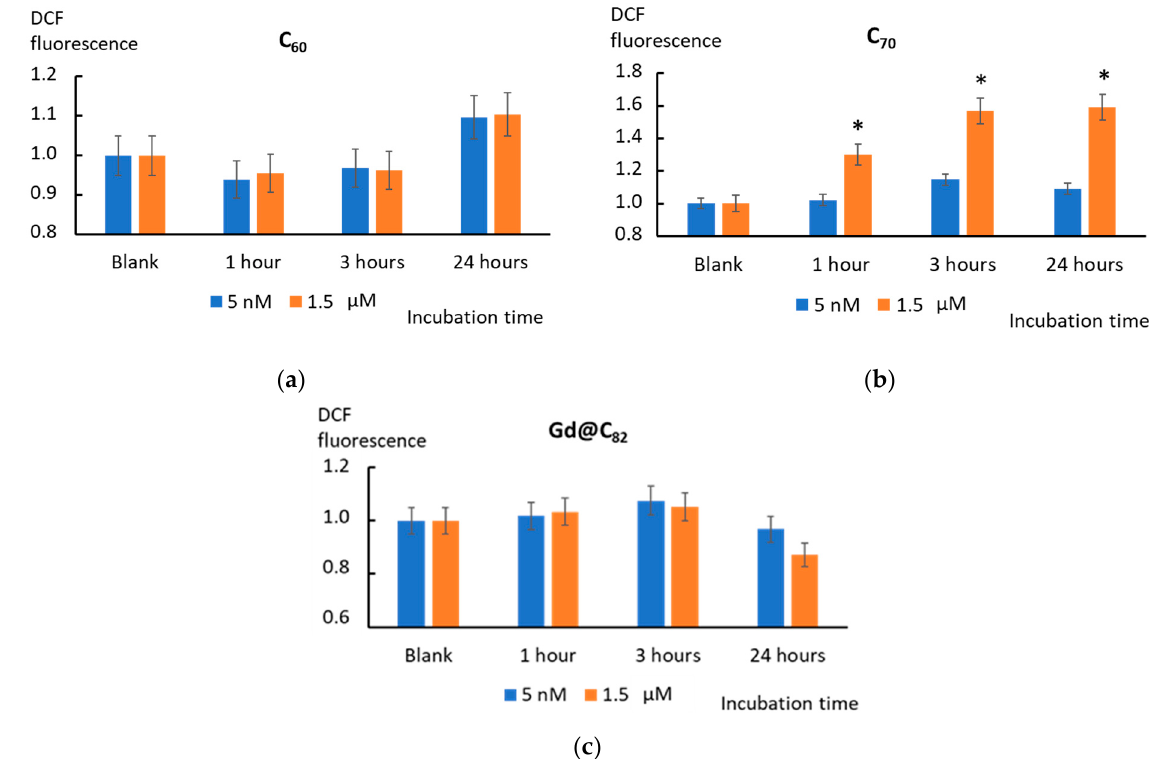
Figure 7. The histograms of intracellular ROS production on the incubation time for C 60 ( a ), C 70 ( b ), and Gd@C 82 ( c ) at the concentrations of 5 nM and 1.5 µM; flow cytometry was used. (*) denotes significant differences with the blank cells, p < 0.01, a nonparametric U-test.